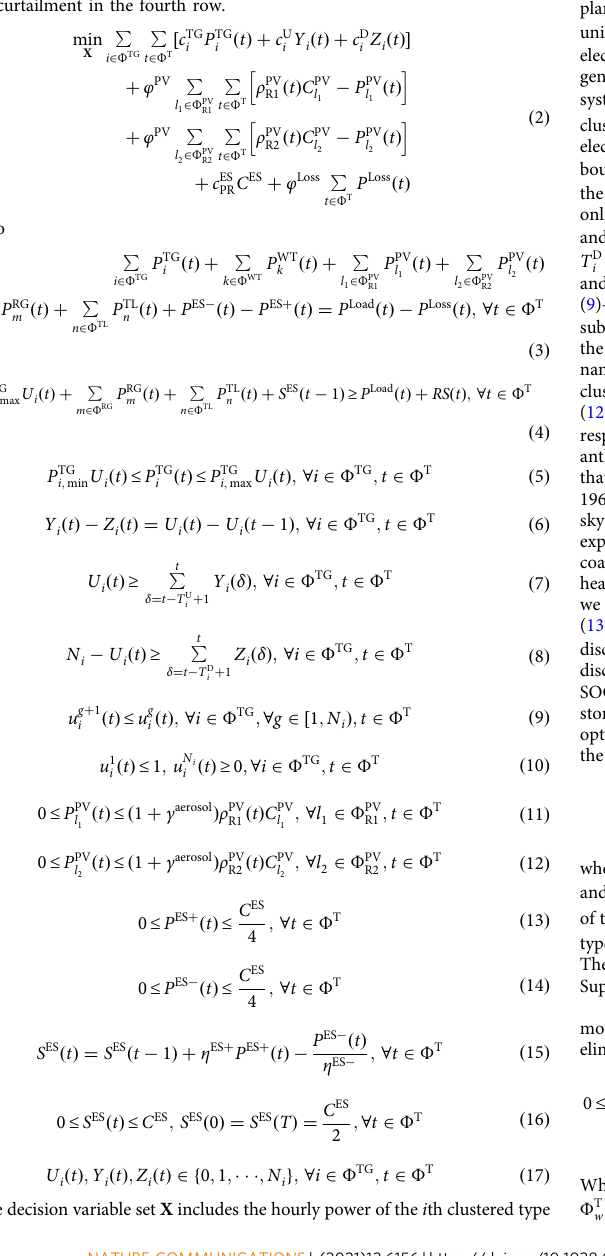
Coal Plant Tracker 41 . Then, the gas- fi red generation capacity can be obtained by subtracting the coal- fi red generation capacity from the thermal generation capacity. Considering that the NG capacity largely remains below 600MW, we divide the thermal power generating units below 600MW into CGs and NGs based on the ratio of the coal- fi red generation capacity to the gas- fi red generation capacity. Due to data limitations, the hourly provincial electric loads from 6/18/2020 to 7/22/2020 are collected from provincial power grid companies or fi tted based on typical provincial daily and annual load curves. In the base case, we consider that the capacity change trends of coal- fi red generators, gas- fi red generators, PV systems, interchange tie-lines, and electricity loads over time in the different provinces or municipalities are the same as the relevant predicted change trends in China referenced from the China Energy and Electricity Outlook 22 . Electricity dispatch model . A CUC model 42 is employed in each province to calculate the CO 2 emissions of CGs and NGs in the different cases, with the advantages of the use of easily available clustered unit data as input to improve the computational ef fi ciency 34 . The objective function in Eq. (2) minimizes the total cost of province-level power systems during the plum rain period, comprising the generation cost of thermal generators (TGs, including CGs and NGs) in the fi rst row, the penalty costs for solar curtailment in R1 (the second row) and R2 (the third row), and the additional storage cost for PV integration and the penalty cost for load curtailment in the fourth row.